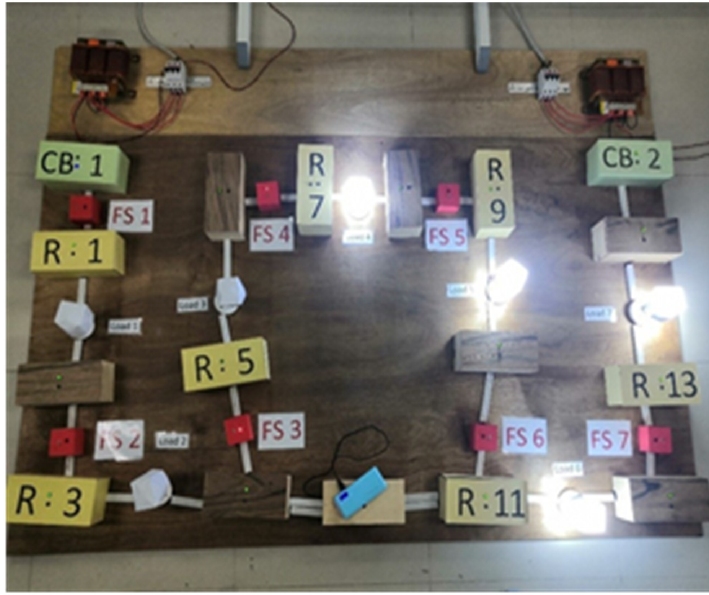
Figure 21. Hardware after restoration for LED Bulb 1.